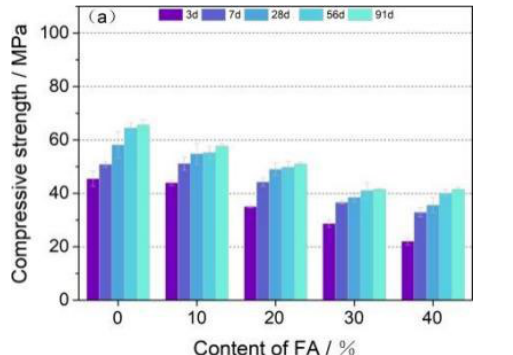
Figure 7. Compressive strength of OPC-LCFA samples. ( a ) Dry. ( b ) Water .